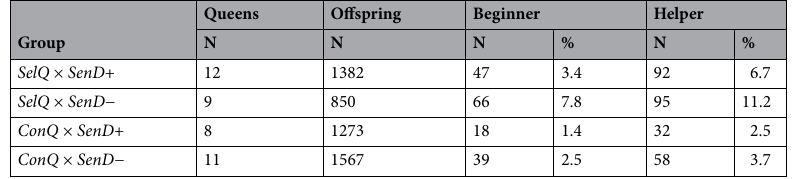
Of the 87 Varroa -parasitised-brood-odour sensitive drones that qualified for insemination, only 26 were used for the insemination of queens since the rest did not have sperm. Of those 26, only 20 queens produced enough offspring to participate further in the experiment. Of the 48 Varroa -parasitised-brood-odour insensitive drones, 22 were used for insemination. Of those, 20 had enough offspring to participate in the experiment. Video observation. The offspring (worker bees) of the one-drone inseminated queens was marked with